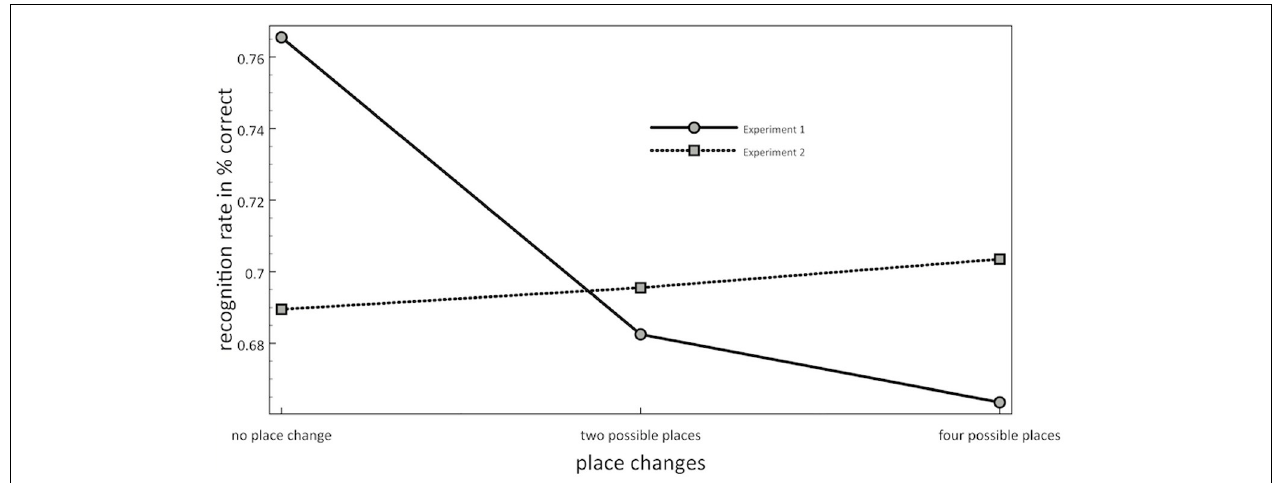
FIGURE 3 | Mean recognition rates (in percent correct) as a function of locations per object (from left to right: 1 location, 2 possible locations, 4 possible locations) and of Experiment (1: solid line; 2: dotted line).